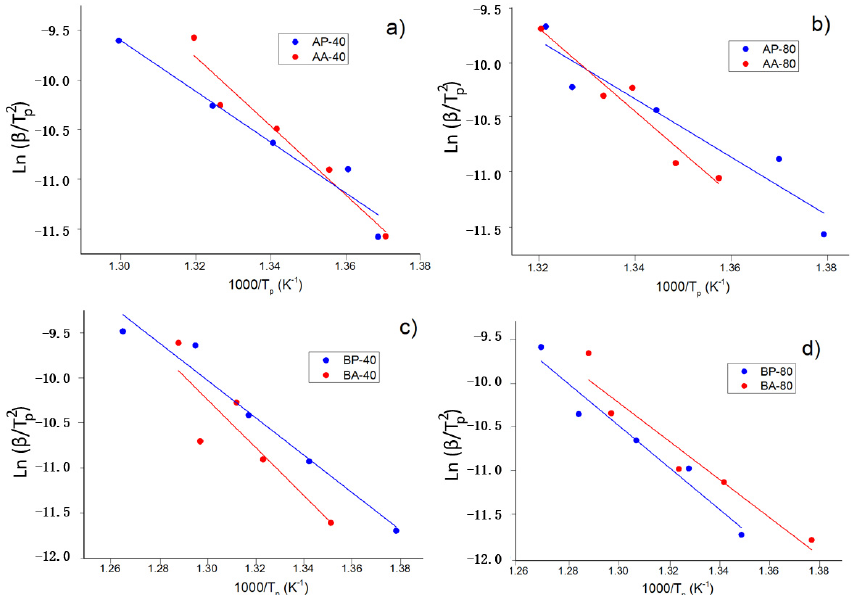
Figure 7. Kissinger linear fitting to determine the activation energy of the crystallization process of the powders and agglomerates (each experimental point corresponds to peak temperatures measured at 5, 10, 20, and 40 K/min). ( a ) Sample A-40h, ( b ) sample A-80h, ( c ) sample B-40h, and ( d ) sample B-80h. Activation energy (and its uncertainity) are given in Table 4.